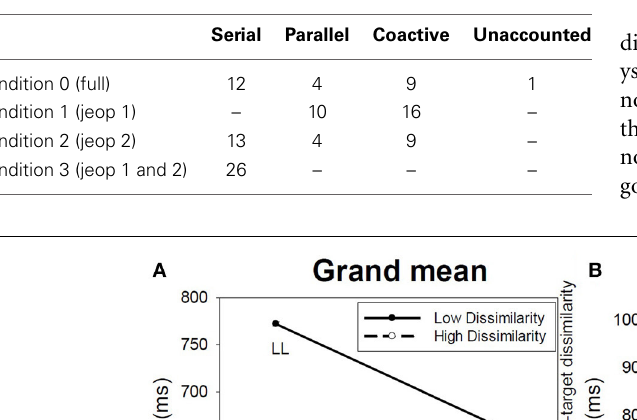
Table 3 | Summary of the inferences across different comparison conditions from Table 1.